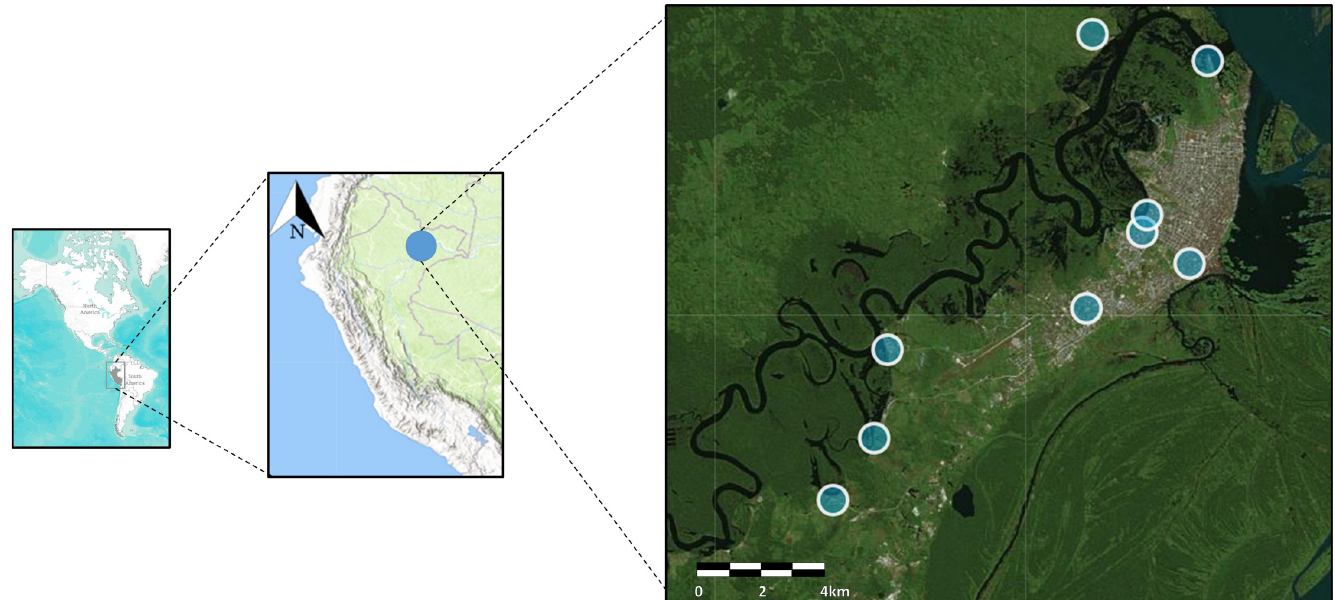
Fig 1. Study sites (blue circles) located in the city of Iquitos and surrounding communities. Map created using open data from openstreetmap.org: OpenStreetMap contributors.